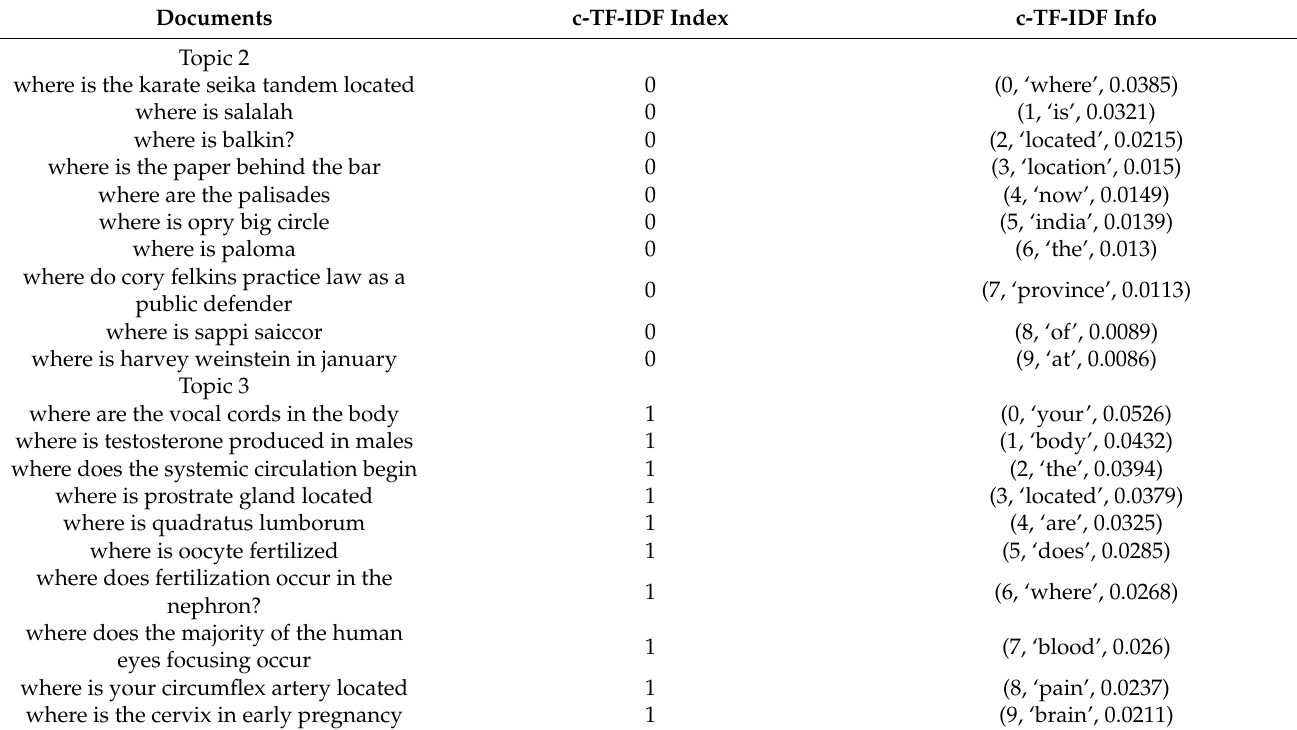
Table 12. Manual annotation example for topics 2, 3 regarding c-TF-IDF representativeness. All